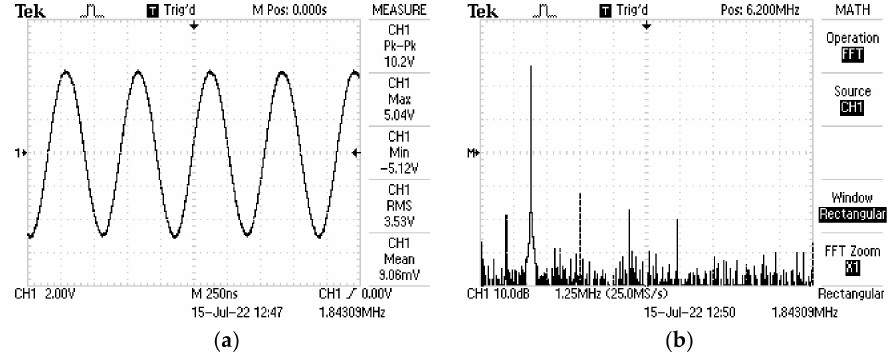
Figure 7. The output waveform of the QO1 at f Q = 1.8432 MHz with C 1 = C 2 = 33 pF and C 12 = 16.5 pF: ( a ) the output voltage; ( b ) the output spectrum with sweep along the x -axis from 0 Hz to 12.5 MHz (at 1.25 MHz scale).